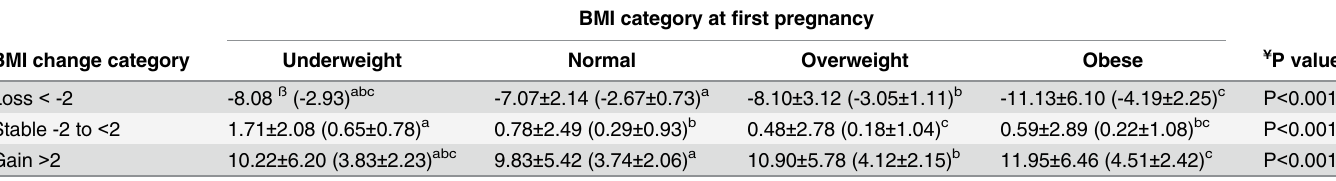
Table 2. Average weight (and BMI) change between first and second pregnancy in relation to BMI category at first pregnancy and BMI change